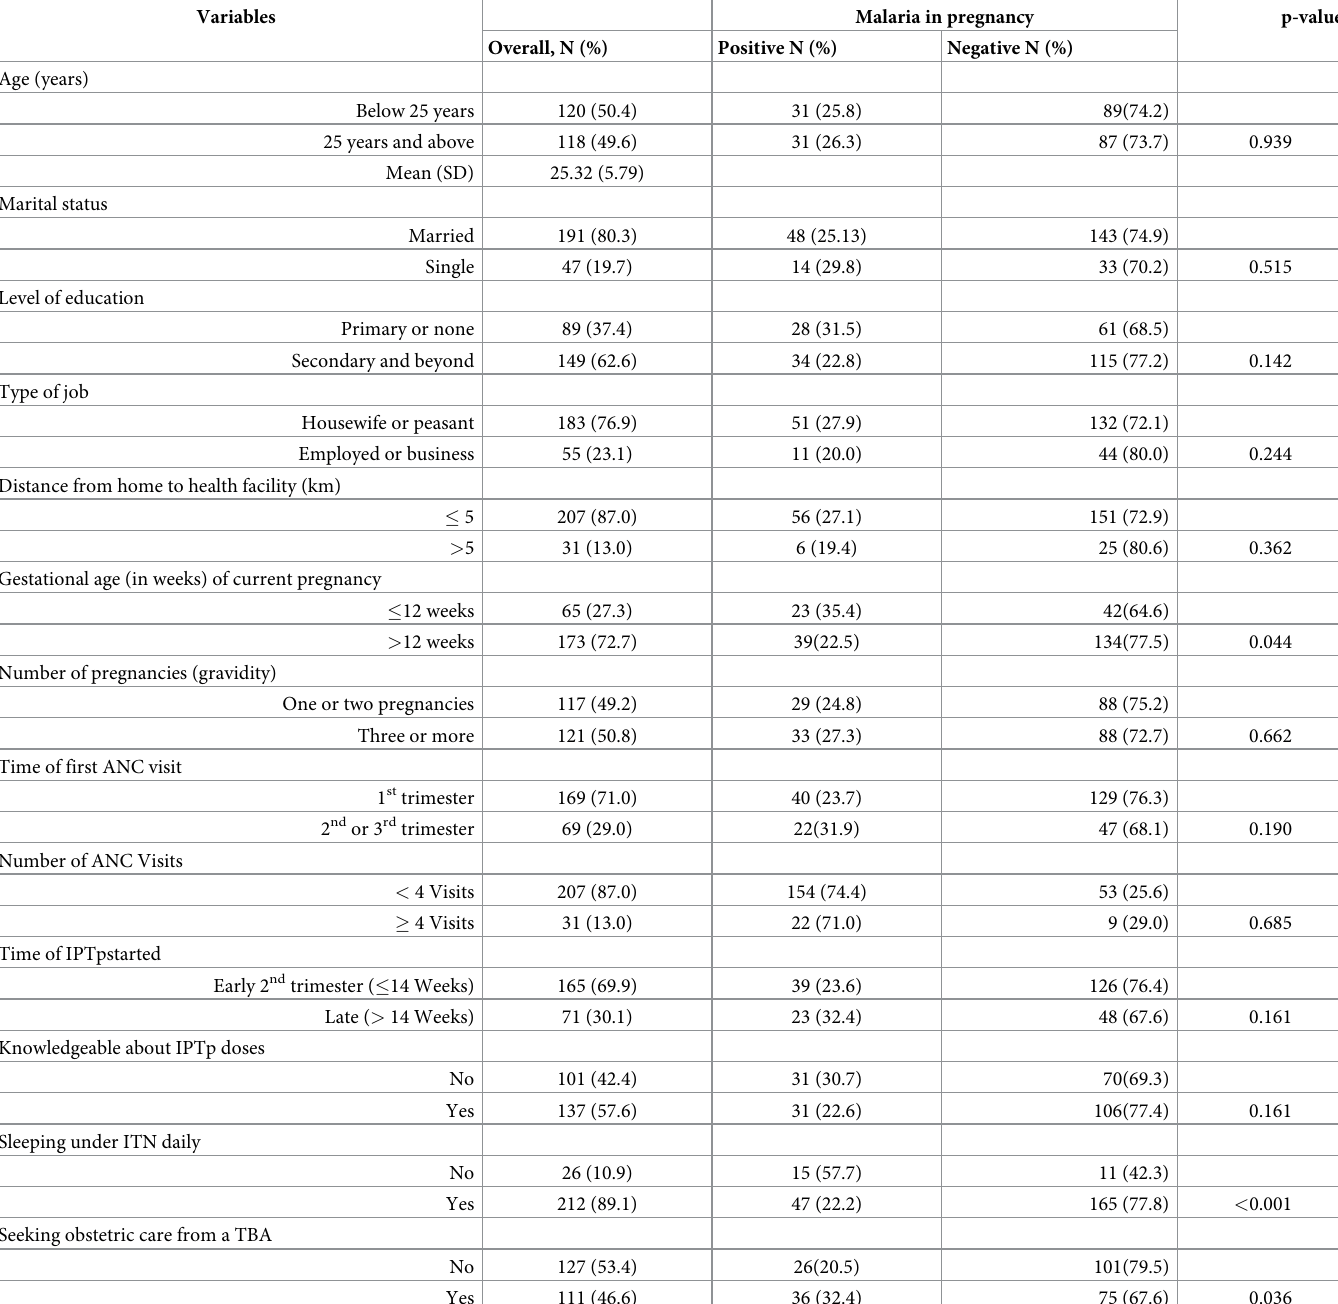
Table 1. Background characteristics of pregnant women and prevalence of malaria in